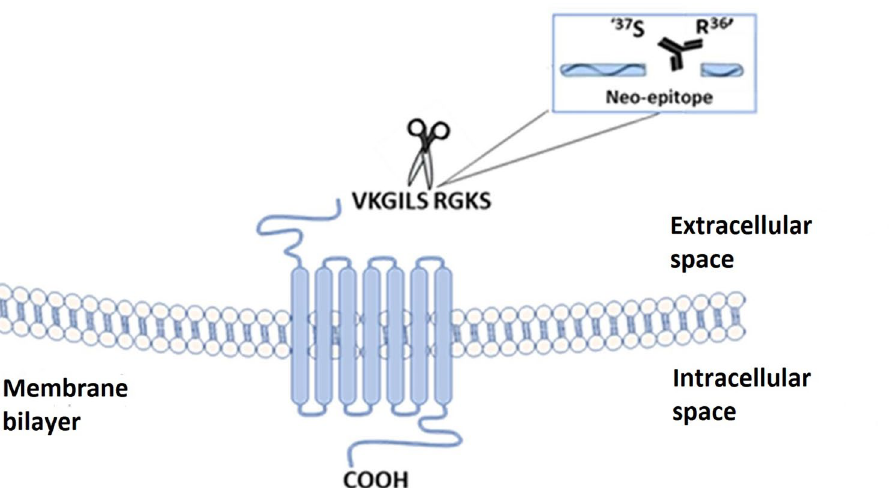
Figure 5. PAR2 receptor activation after cleavage of its N-terminus by serine proteases. The cleavage site between the 36 and 37th amino acid is depicted and the remaining 36-amino-acid fragment (not all 36 amino acids are depicted) is released upon receptor activation.